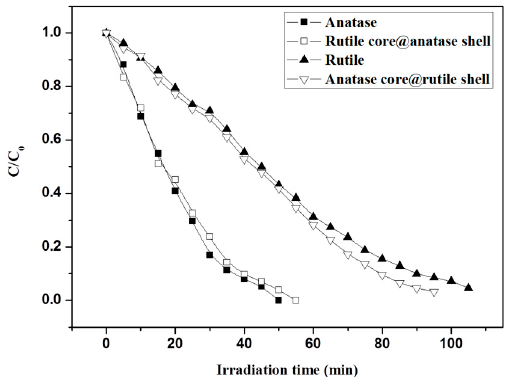
Figure 9. Photodegradation curves of Rhodamine B on anatase core@rutile shell TiO 2 nanofibers and rutile core@anatase shell TiO 2 nanofibers as well as pure anatase and rutile TiO 2